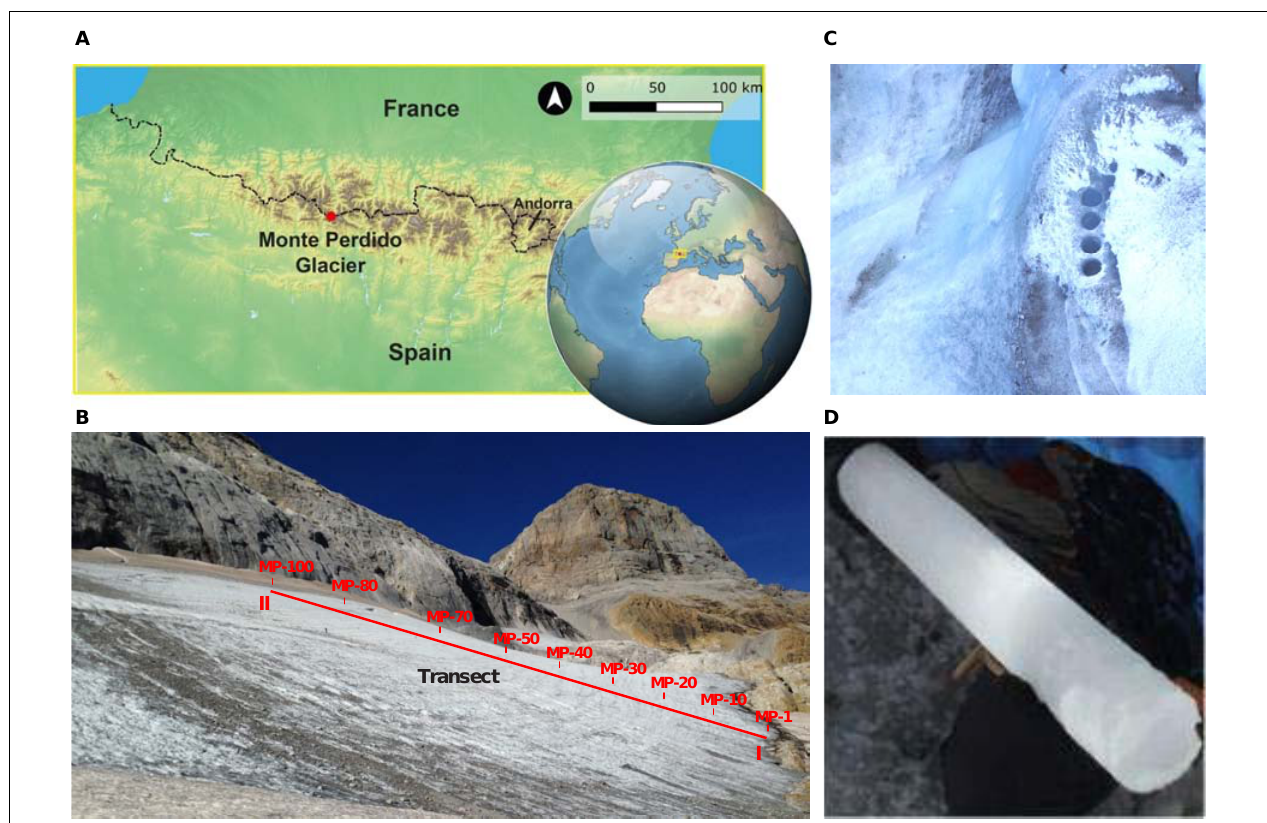
FIGURE 1 | Geological setting of samples collected at Monte Perdido glacier. (A) Location of MPG. (B) Picture of Monte Perdido glacier where altitudinal transect is indicated. Sampling points go from the oldest (MP1) to the modern (MP100). (C) Detailed view indicating that every sample consisted of three to four drilled cylinders. (D) Example of an ice